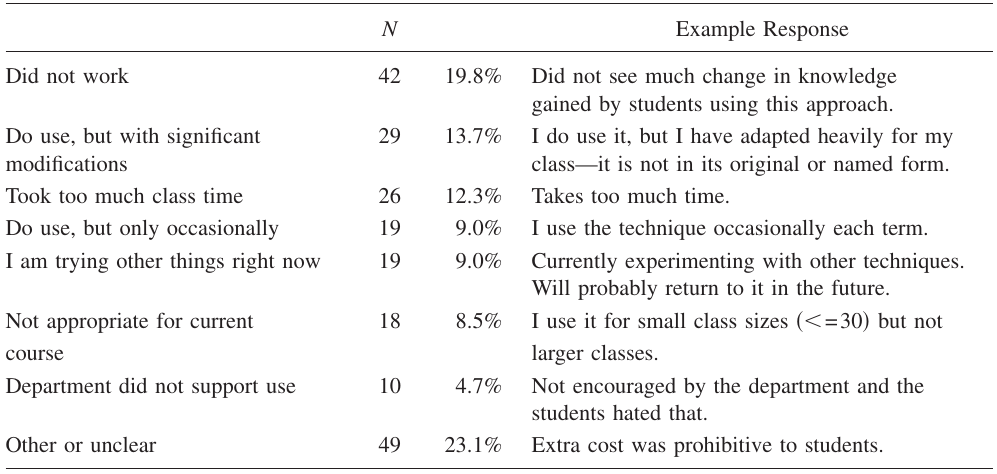
TABLE X. Categorization of open-ended responses (cid:1) N =212 (cid:2) to the question “Why do you no longer use (cid:4) discontinued RBIS (cid:5) ?” Based on reasons given for four RBIS that had highest priority for follow-up